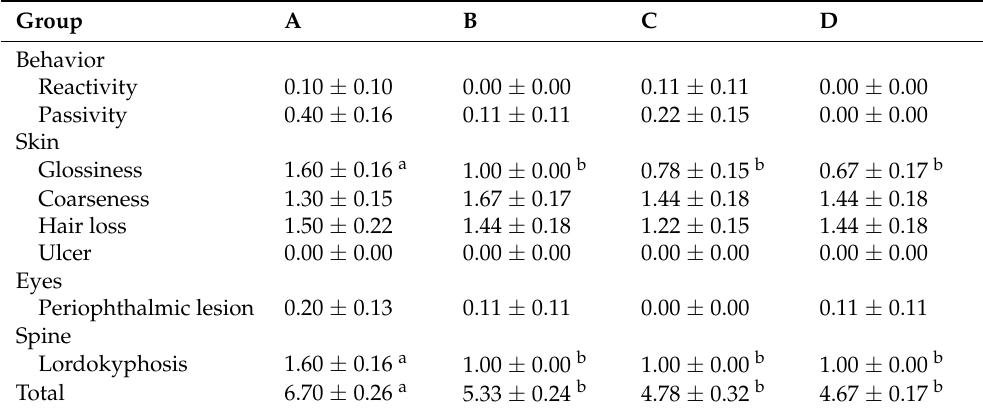
Table 5. Effects of SPE administration on aging index assessment scores of male SAMP8 mice. Group